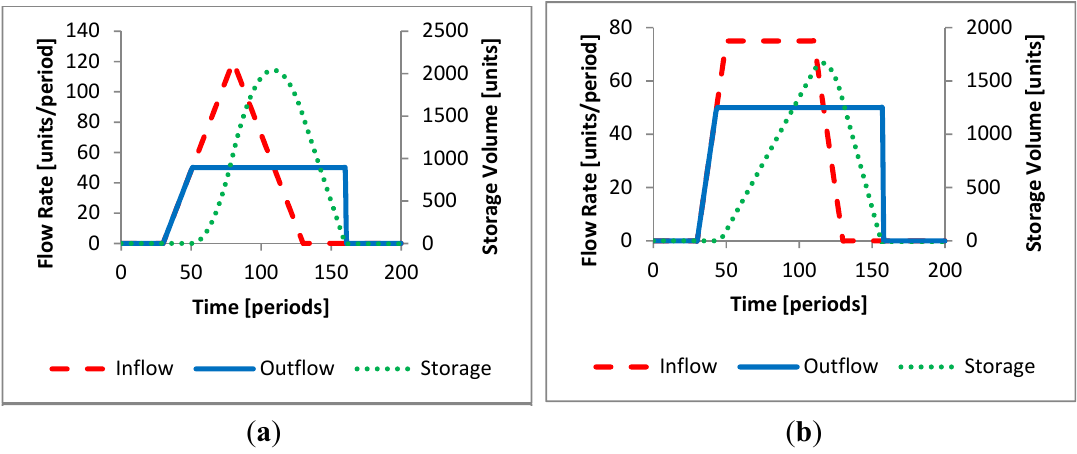
Figure 8. Short forecast peak minimization operation rule (with flooding prevented) for ( a ) Triangular hydrograph and ( b ) Broad peak